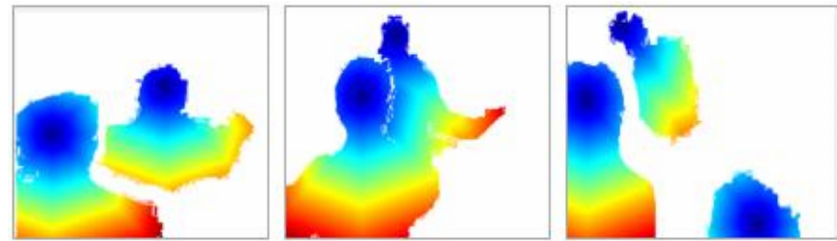
Figure 6. Energy based point cloud results obtained over frames of the PCDS